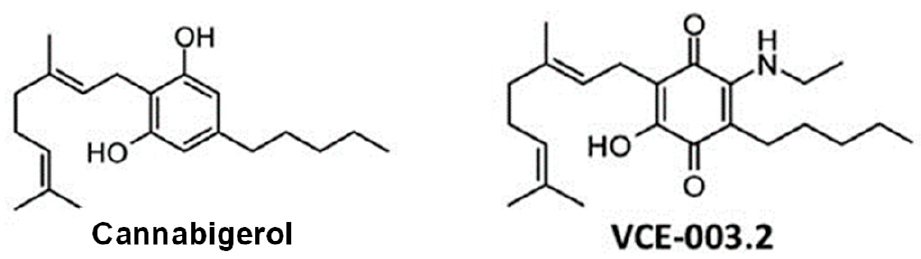
Figure 8. Chemical structures of cannabigerol (CBG) and VCE-003.2 (adapted from [19]).